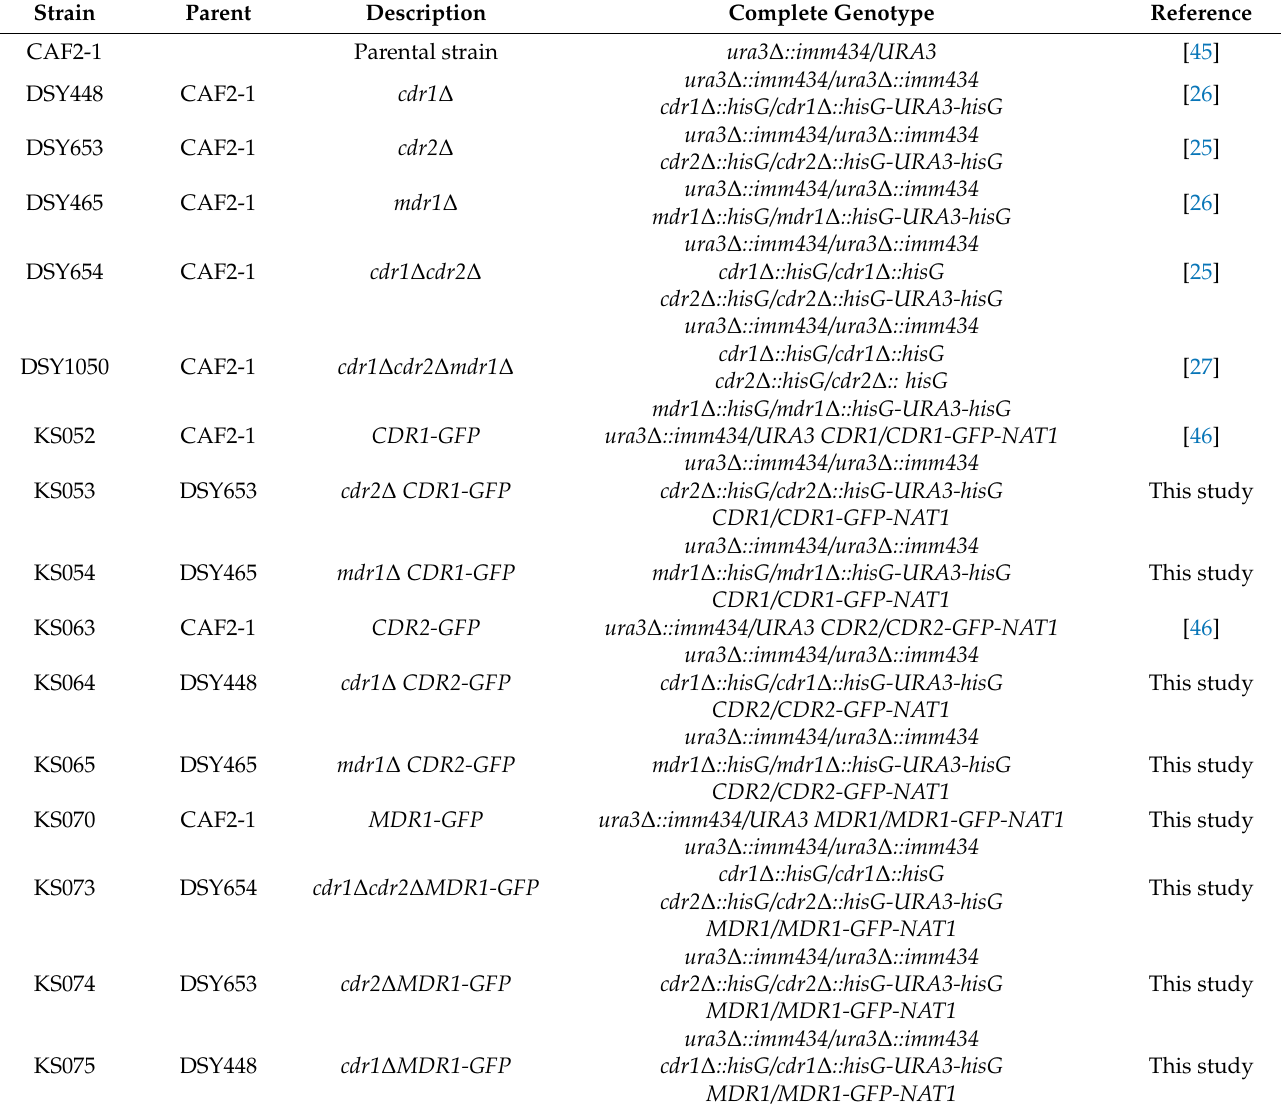
Table 1. Candida albicans Strains Used in This